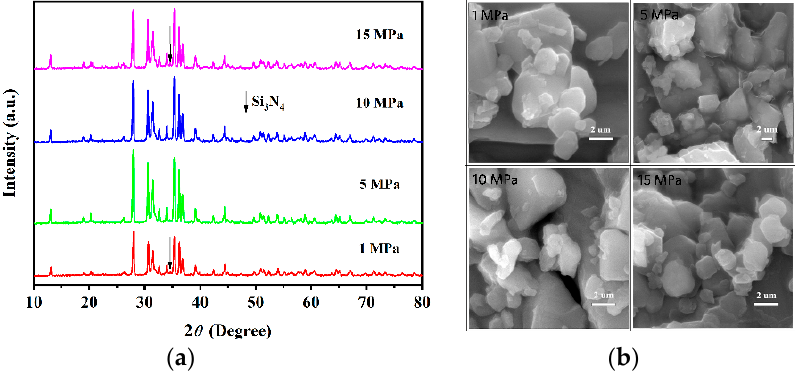
Figure 4. ( a ) XRD patterns and ( b ) SEM images of the samples with different pellet pressure.